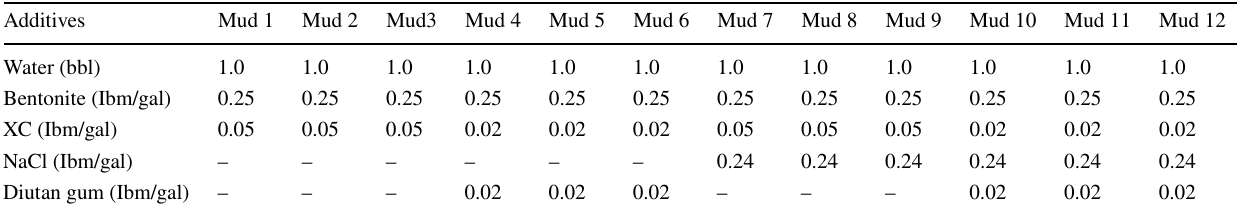
Table 2 Compositions of the drilling mud formulations Additives